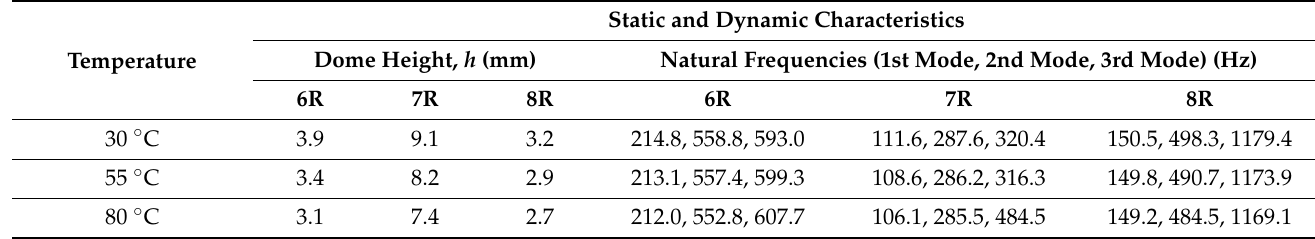
Figure 3. Manufactured and mode shapes of different THUNDER devices (the color represents the deformation). ( a ) Manufactured shapes. ( b ) First natural frequency mode shape. ( c ) Second natural frequency mode shape. ( d ) Third natural frequency mode shape. Table 3. Characteristics of THUNDER devices at different